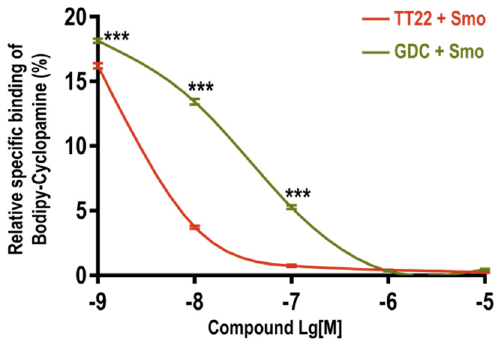
Figure 5. TT22 competes with Bodipy-cyclopamine to bind with Smo. Competitive binding of Bodipy-cyclopamine to Smo with different concentrations (10 − 9 –10 − 5 M) of Smo antagonists: TT22, GDC-0449 (GDC) in HEK293 cells transiently transfected with human wild-type Smo. The binding of Bodipy-cyclopamine (green) was detected by flow cytometry. All data are means ± SEM (two-way ANOVA). *** p < 0.001.